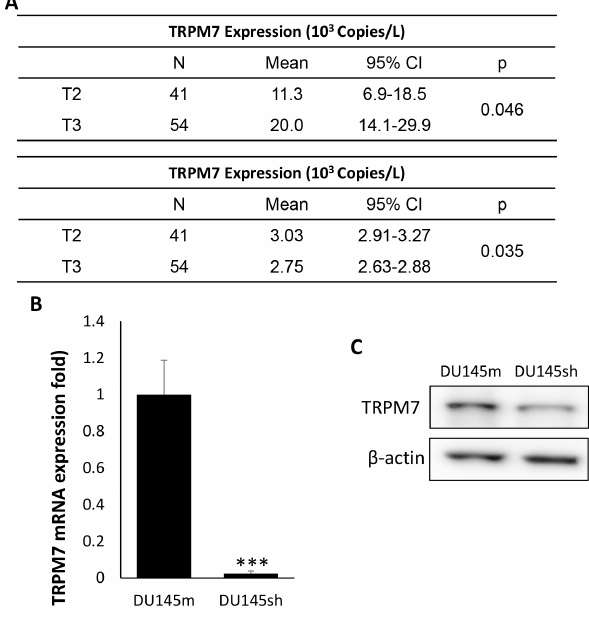
Fig. 1. Expression of TRPM7 related to prostate cancer and downregulation of TRPM7 in prostate cancer cell. The ex- pression of TRPM7 in human prostate cancer tissue sample (A). Knockdown efficacy of TRPM7 in mRNA (B) and protein level (C) in DU145 cell line. β -actin served as the loading control. All data are expressed as the mean ± standard deviation from three independent experiments. * p < 0.05; ** p < 0.01; *** p < 0.005 versus